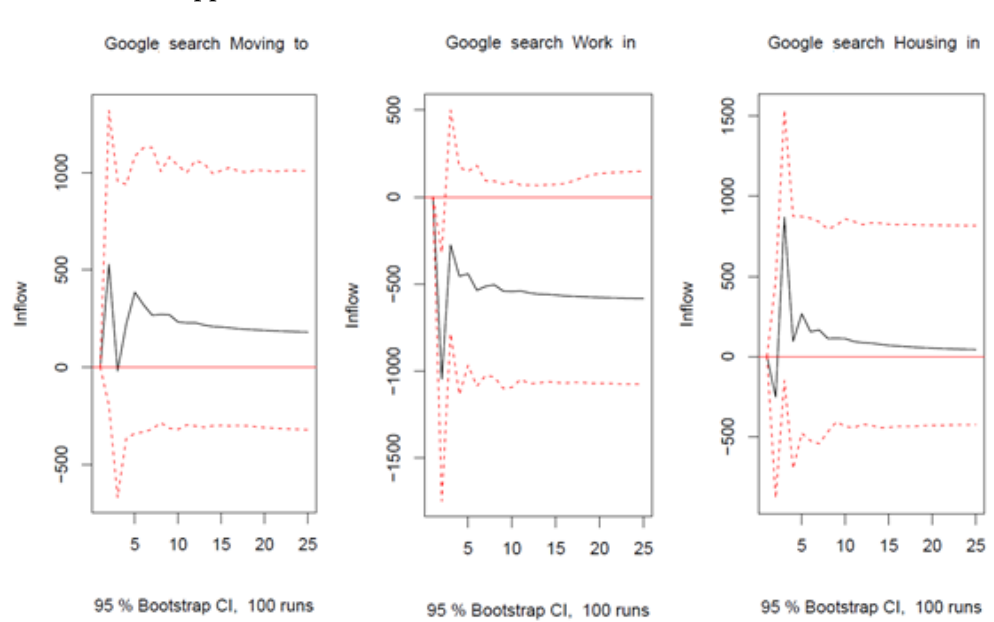
Figure A3. VECM (1) with centered seasonal dummies: orthogonalized impulse responses from a shock in Google searches on migration inflow in Moscow over 24 months.